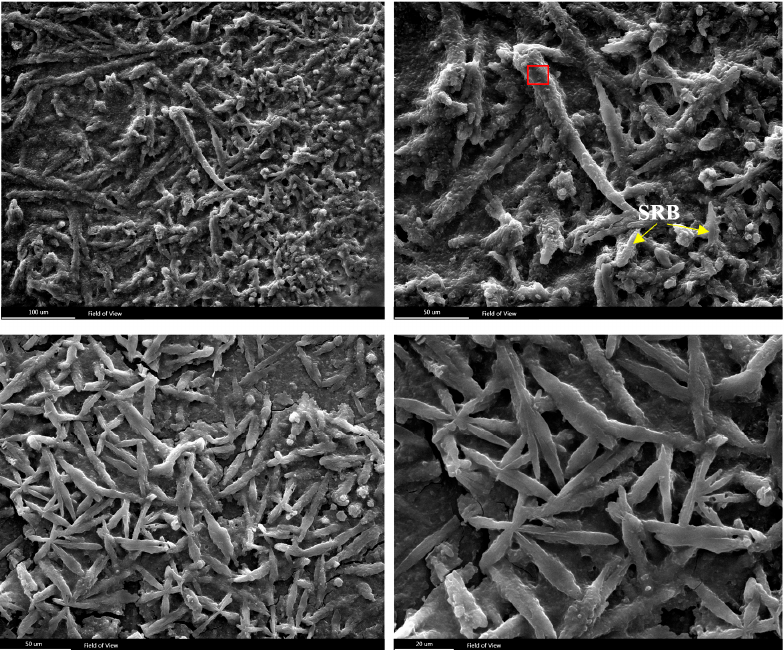
Figure 12. SEM images of SRB growth in specific media inoculated by the surface scratches of the corroded sample (all pictures are from similar features with different magnifications).